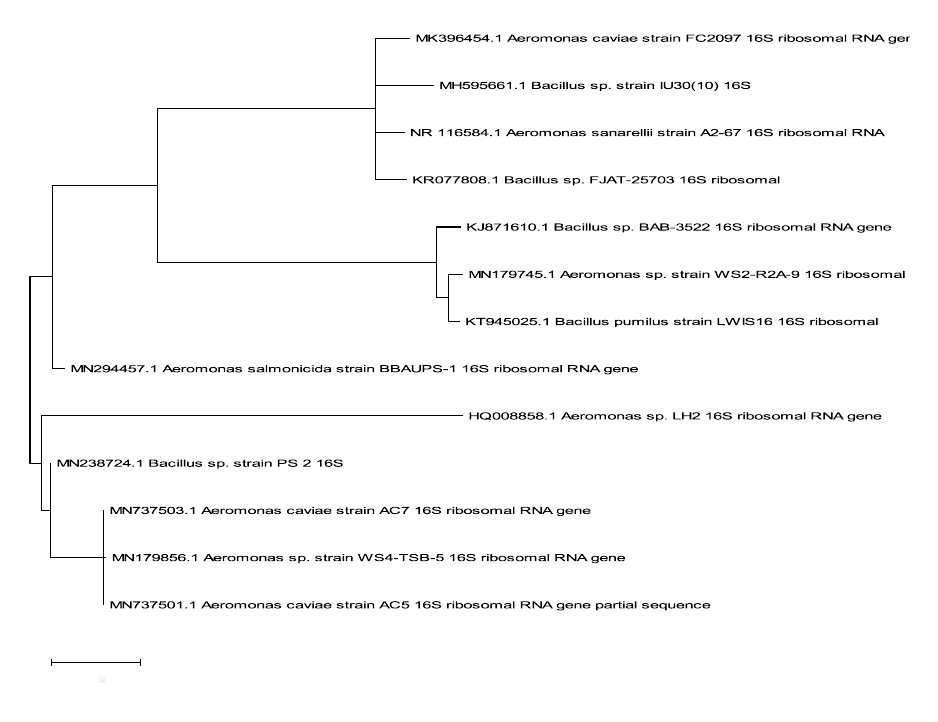
Fig. 6. Phylogenetic tree showing the relationship of bacterial communities growing during biostimulation process. The accession numbers for all strains used in tree construction are indicated in the